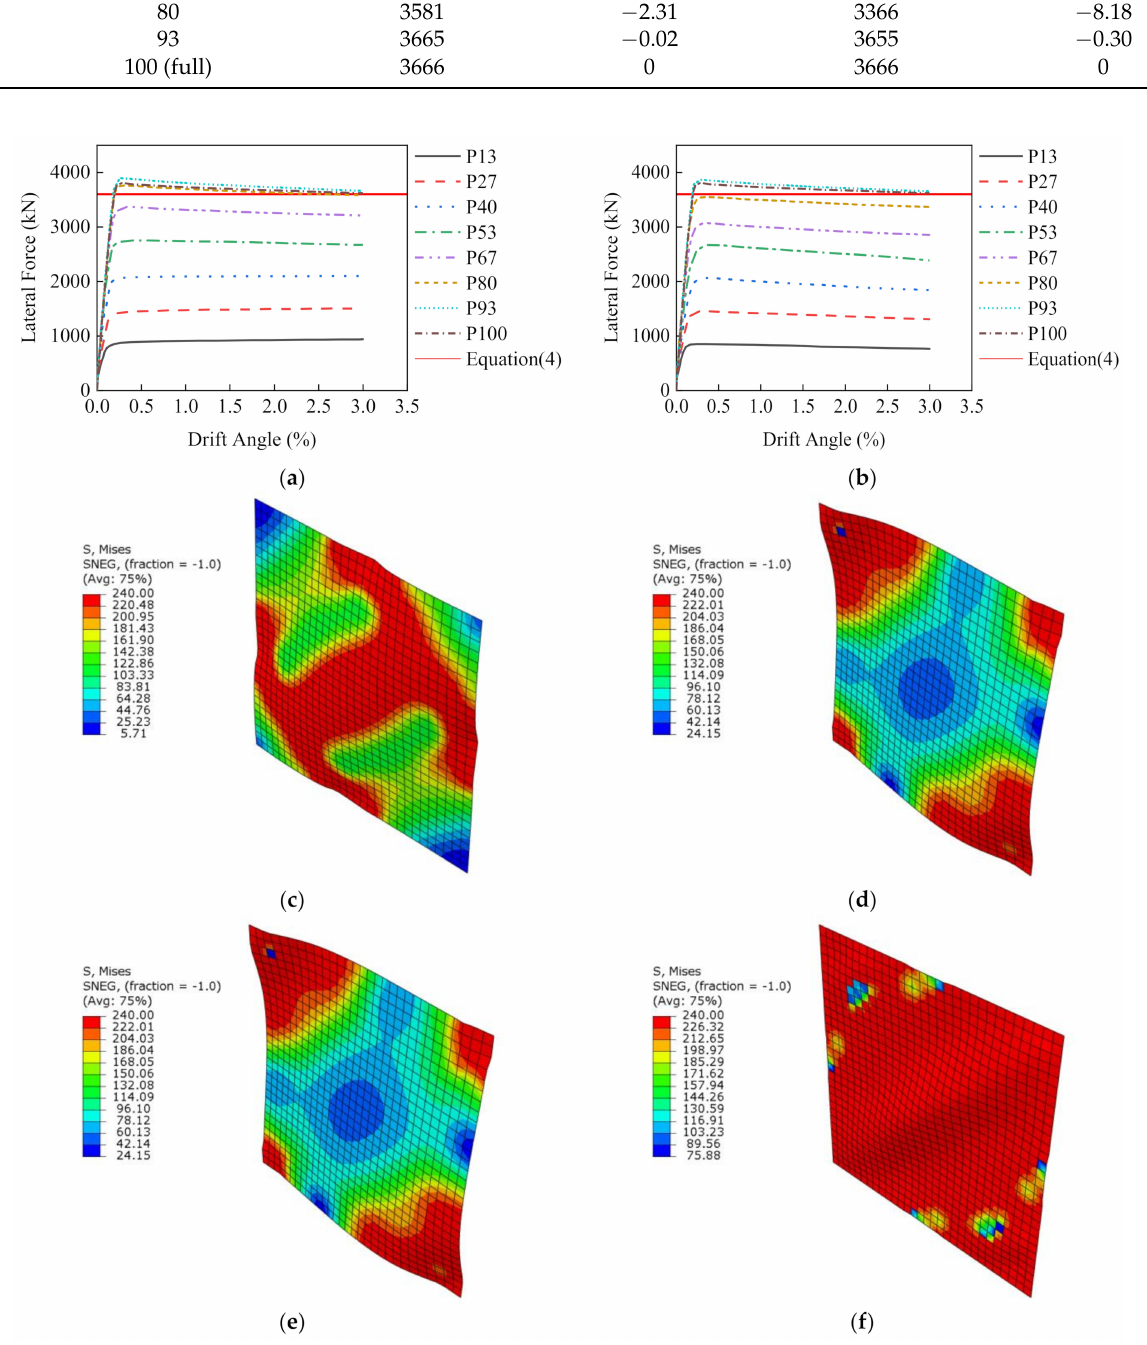
Figure 10. Load–displacement curves and stress distributions at 3% drift of S3 and S3R